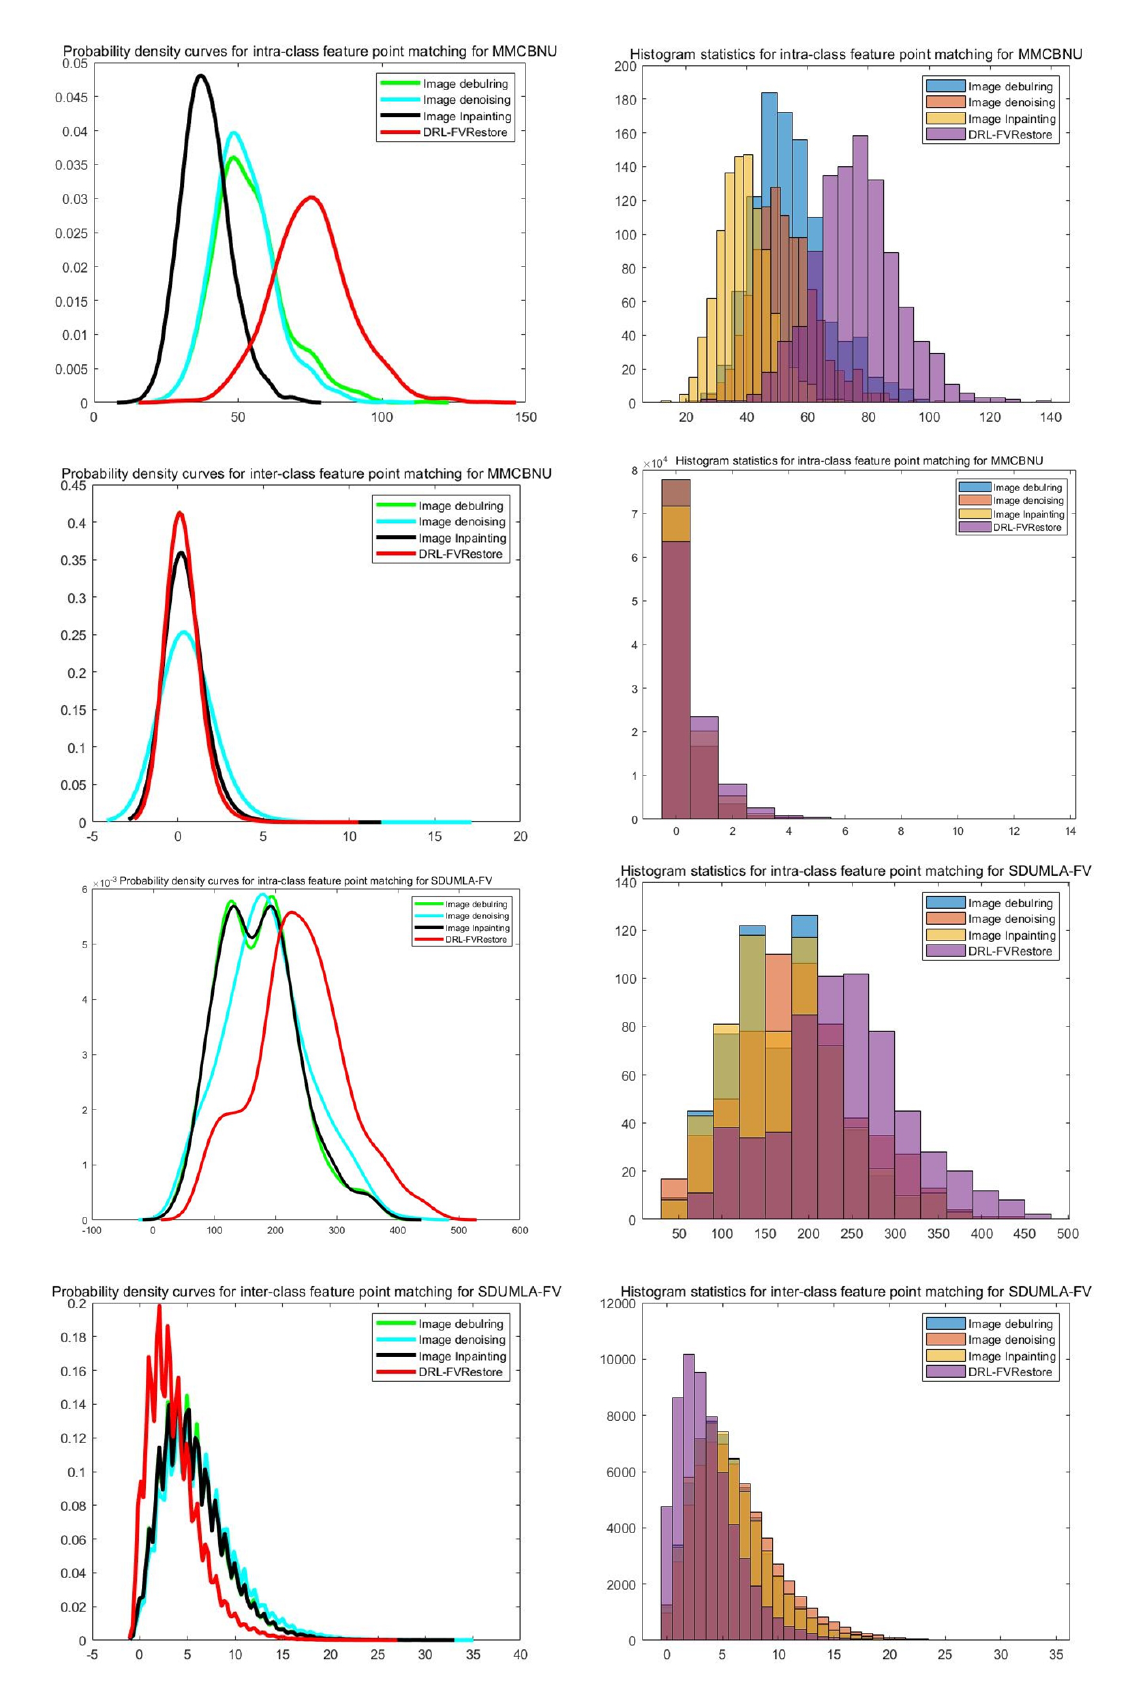
Figure 15. The intra-class and inter-class probability density distribution plots and feature point histogram statistical plots of DRL-FVRestore on the on the MMCBNU and SDUMLA-FV